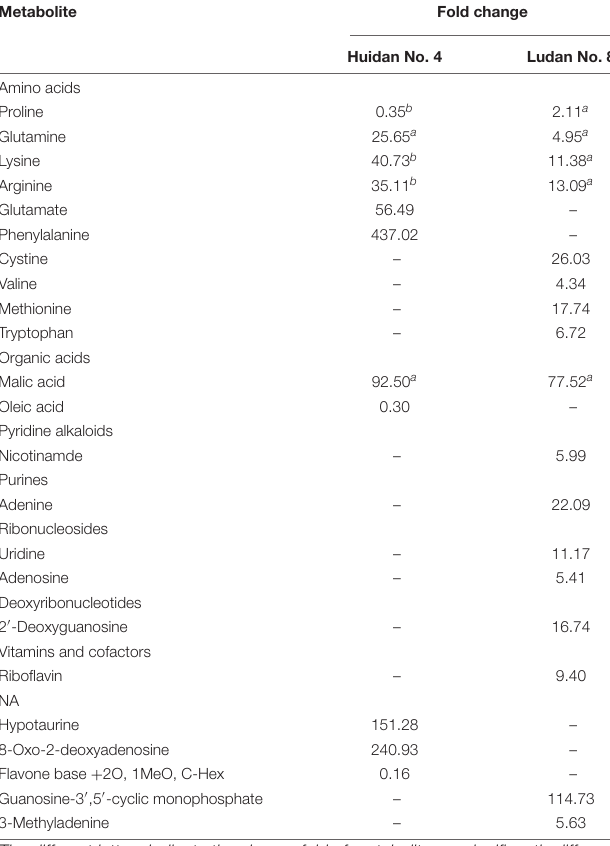
TABLE 1 | Metabolites and their change fold in roots of Huidan No. 4 and Ludan No. 8 exposed to lead. Metabolite Fold